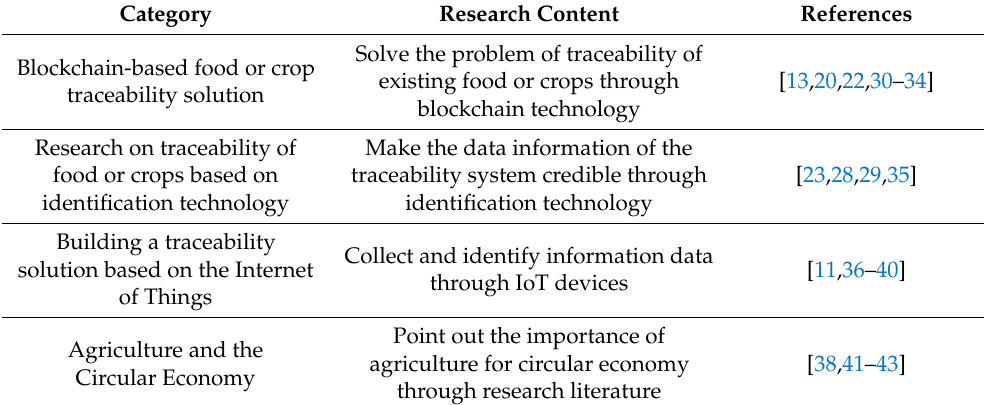
Table 1. Research review